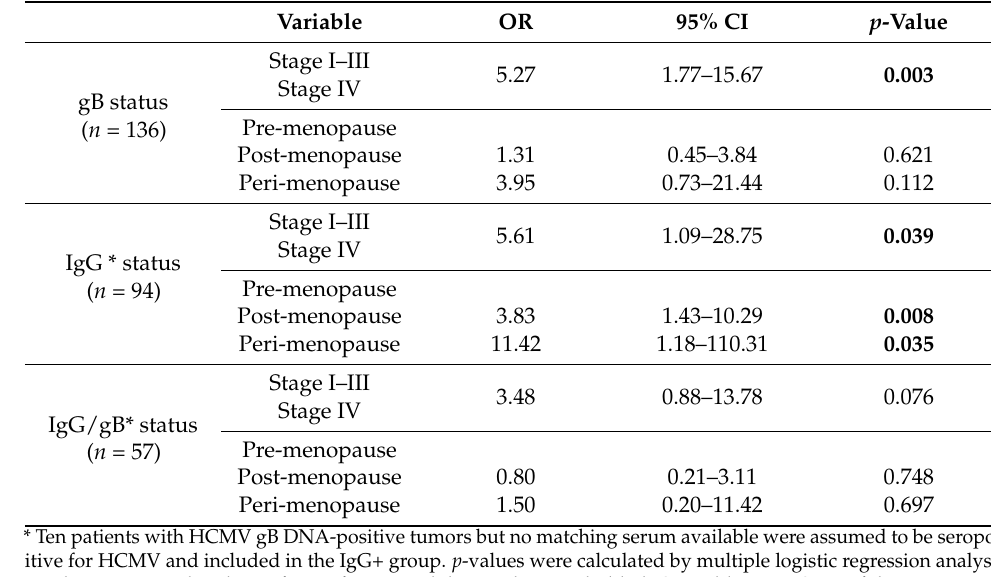
Table 6. Multivariate analysis of patient characteristics identified by univariate analysis to determine the odds ratio of being HCMV gB DNA and/or IgG positive.